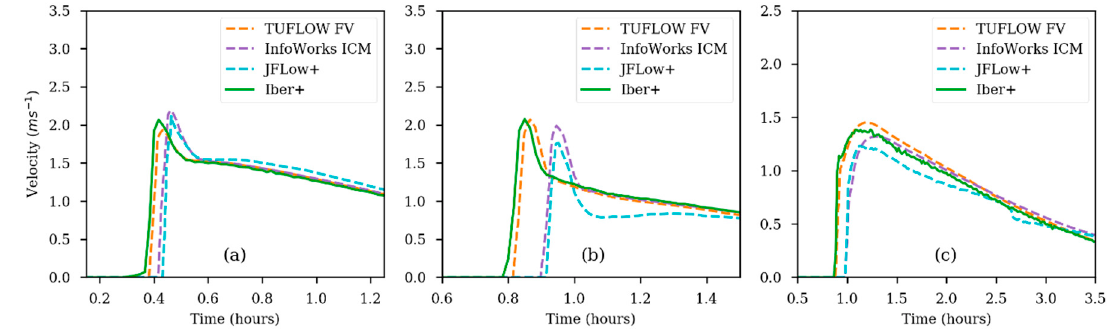
Figure 11. Time series of velocity for Test 5 obtained with different numerical models at Point 1 ( a ); Point 3 ( b ); and Point 7 ( c ).